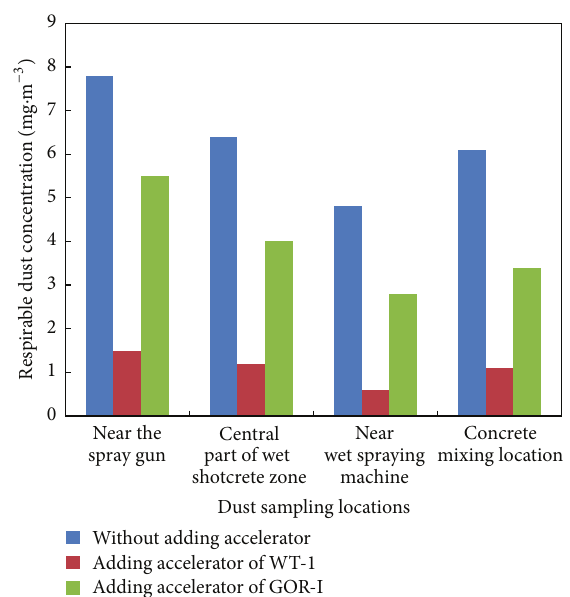
Figure 11: Comparison chart of respirable dust